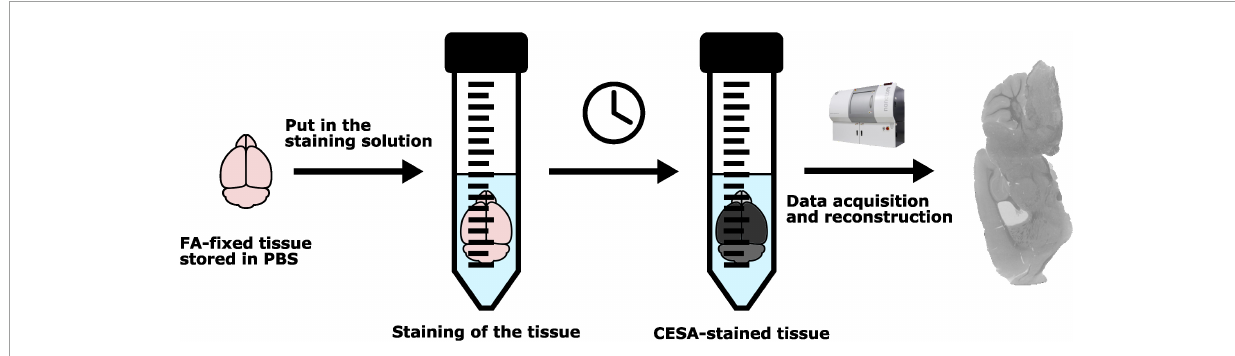
FIGURE2 Schematic overview of the staining protocol.